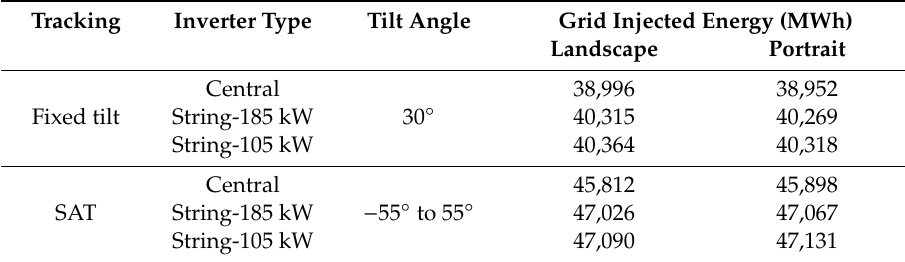
Table 3. Grid-injected energy; 9.65 m pitch; String-185 kW = SUN2000-185KTL; tring-105 kW = SUN2000-105KTL. SAT: single-axis